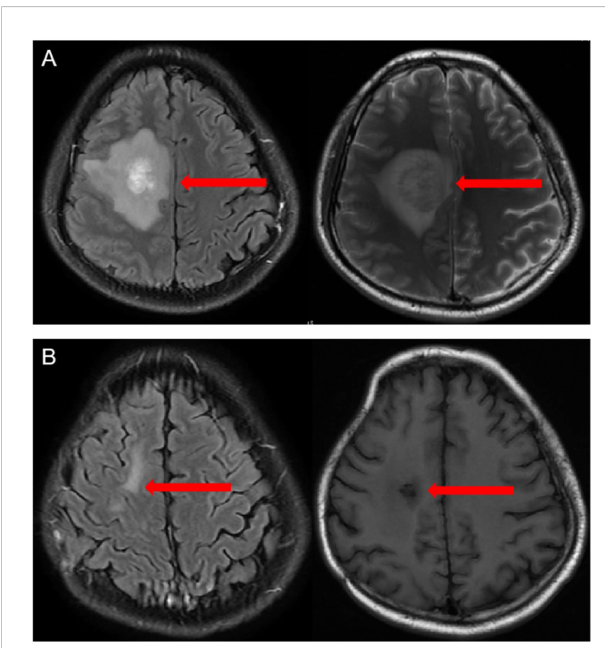
FIGURE 1 (A) Contrast-enhanced magnetic resonance angiogram showing areas of signal abnormality in both the right temporal lobe and frontal lobe with areas of contrast enhancement in March 2022 (B) Contrast- enhanced magnetic resonance angiogram showing that the lesion disappeared without obvious enhancement 3 months after the CAR T cell infusion, indicating that the patient achieved complete remission. The red arrow represents the